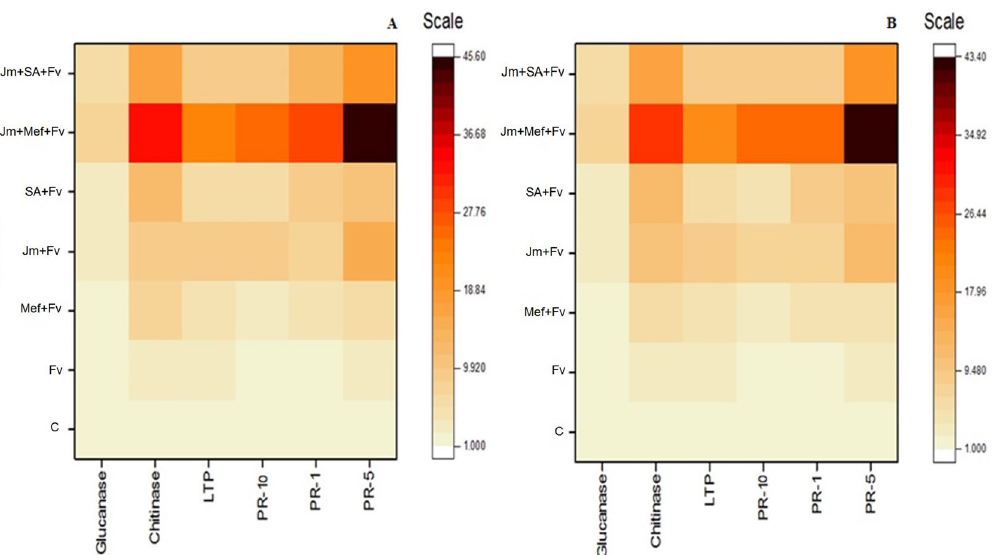
Figure 3. Heat maps showing the effect of seed treatments with J. mimosifolia and control formulations on relative expression profiles in maize leaves of selected defense-related genes 72 h after inoculation of stems with F. verticillioides in ( A ) pot experiment ( B ) field experiment. Relative transcript abundance was determined using RT-qPCR. Values given with color scale represent fold up-regulation. Data represent means of 2 years’ pooled experiments with three replicates for both pot and field experiments. Data are expressed as mean ± standard error of three replicates shown in Supplementary Tables 4 and 5. See Table 1 for